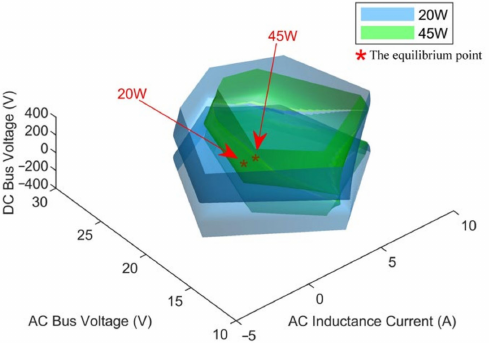
Figure 19. The 3D RAS of microgrids with the battery in charging mode (CPL power was 20 W and 45